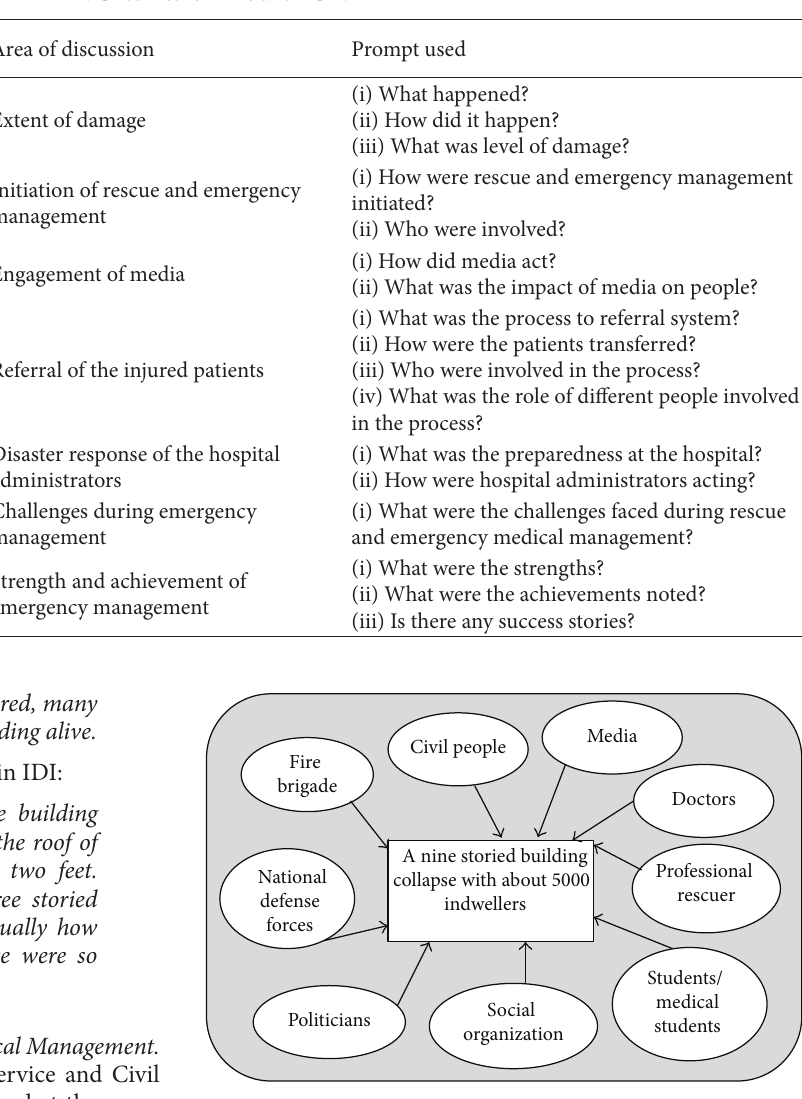
Figure 1: Responses just after the Savar disaster